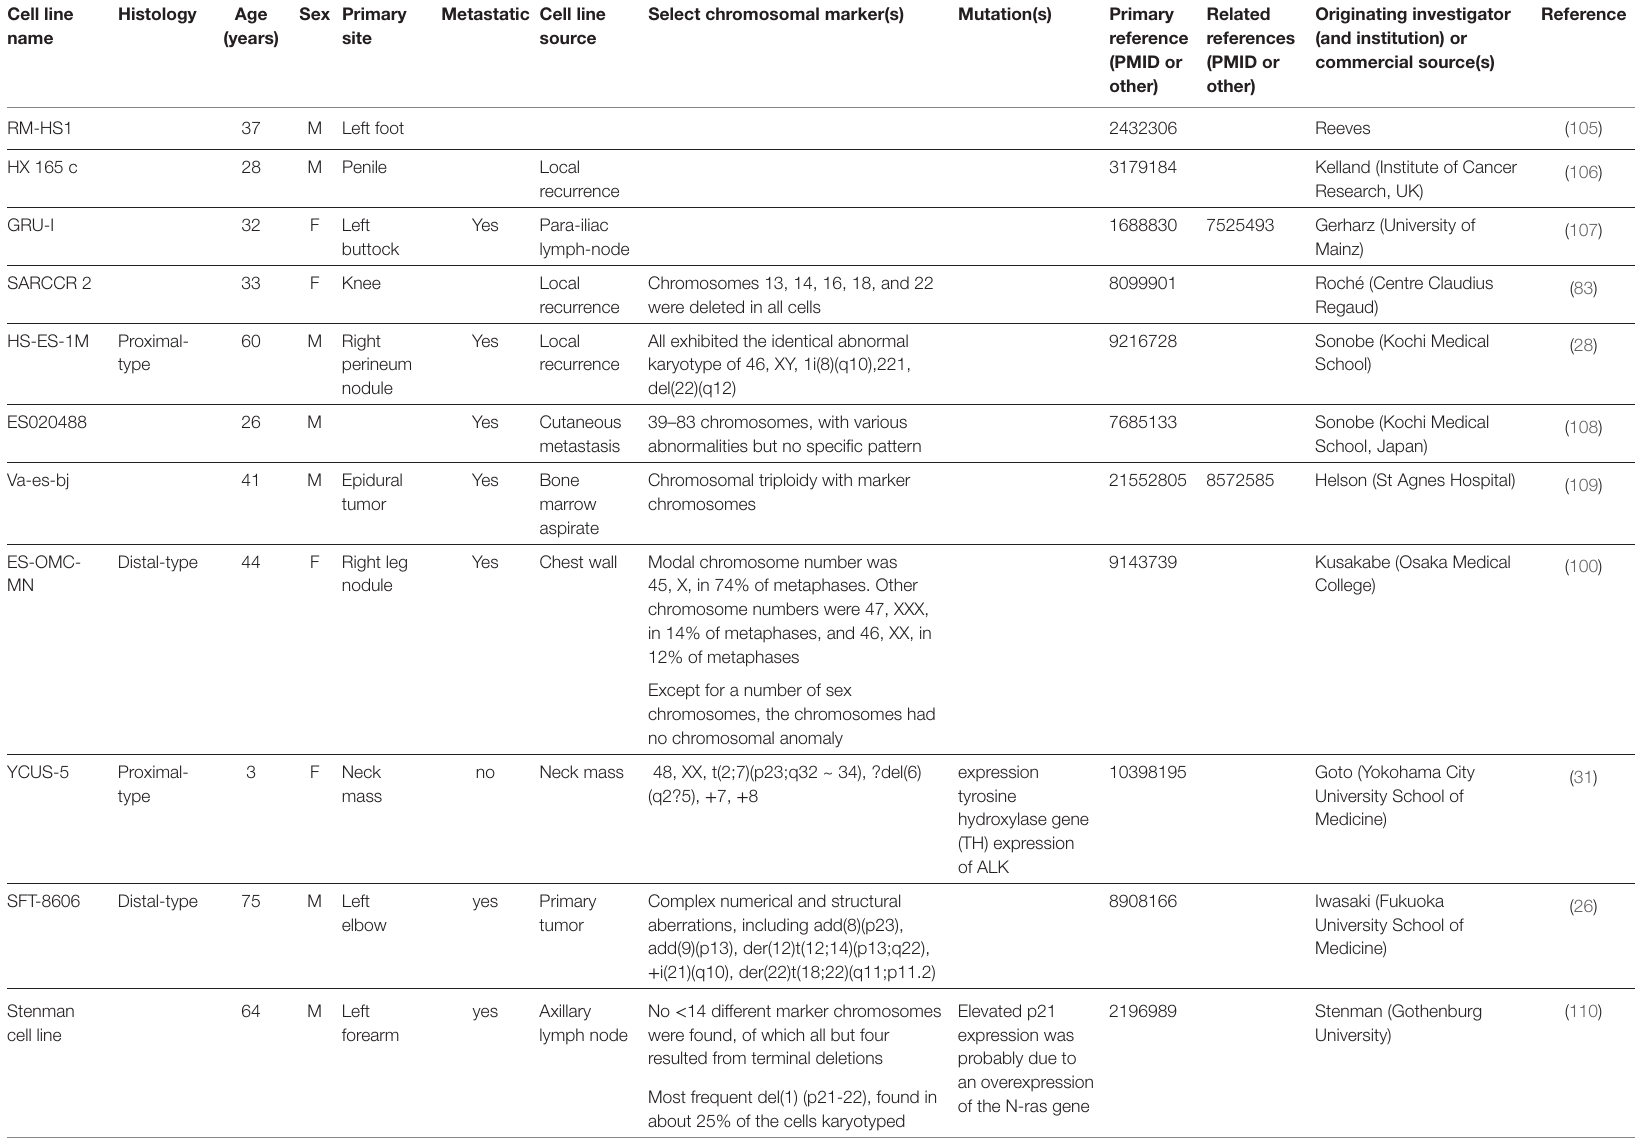
TABLe 3 | Demographic and biological features of human epithelioid sarcoma cell